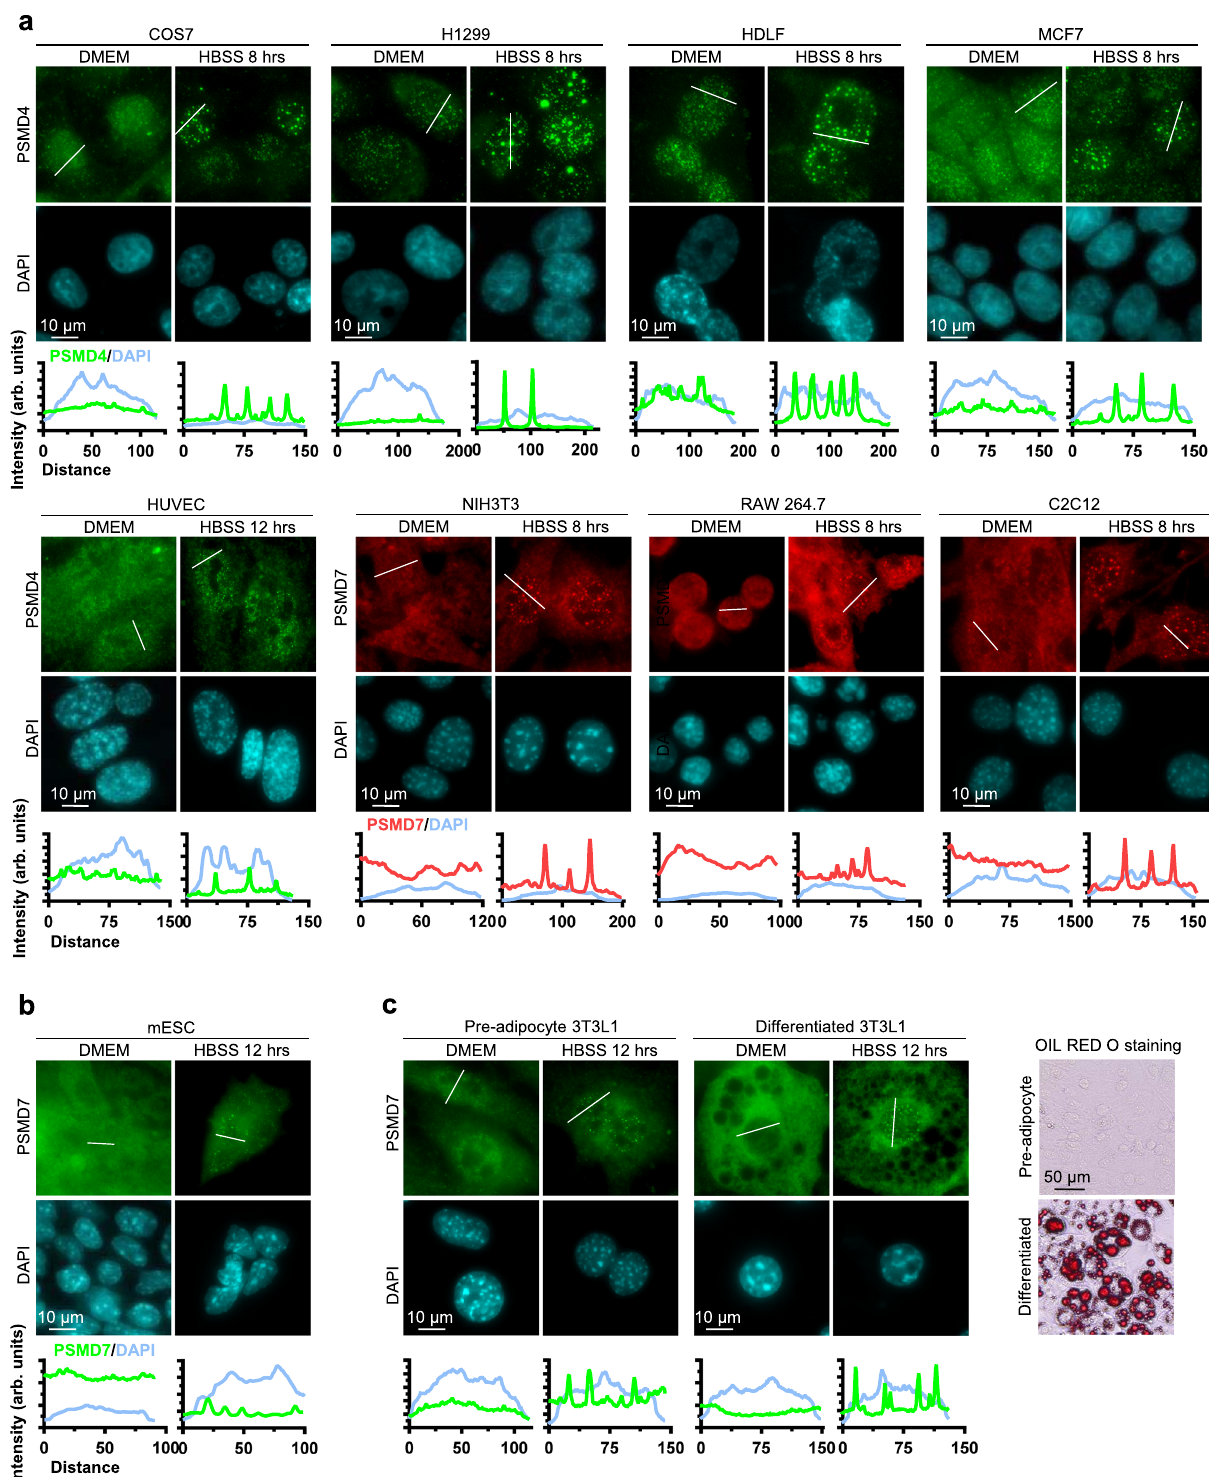
Fig. 4 SIPAN are a general phenomenon common to many mammalian cell types. a , b Immunostaining of endogenous PSMD4 or PSMD7 in diverse cell types, showing that these proteins localize in nuclear foci following incubation in HBSS. SIPAN are observed in normal primary cells (e.g., HDLF: primary human lung fi broblasts, HUVEC: human endothelial cells, mESC: mouse embryonic stem cell); immortalized cells (e.g., NIH3T3: mouse embryonic fi broblasts, C2C12: mouse myoblast cell line, 3T3L1: mouse preadipocytes); transformed (e.g., Cos7: Transformed monkey kidney cells, RAW264.7: Abelson murine leukemia virus transformed macrophage) and tumoral cells (MCF7: human breast cancer, H1299: human non-small cell lung cancer). c Immunostaining of PSMD7 in mouse pre-adipocytes 3T3L1 and differentiated adipocytes showing that this protein localizes in nuclear foci following incubation in HBSS. Right panel, Oil Red O staining was conducted to control for adipocyte differentiation (representative images from 3 independent